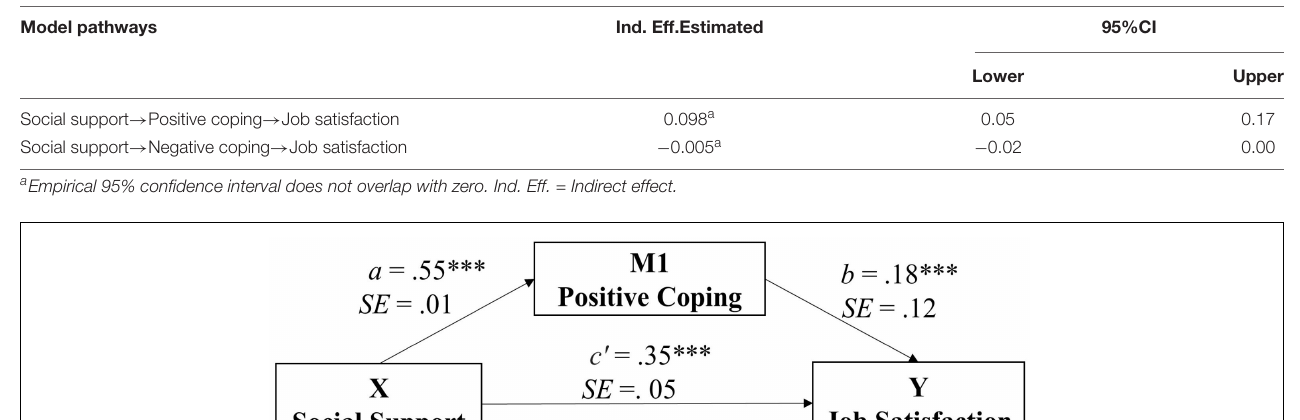
TABLE 2 | Indirect effects and 95% confidence intervals.